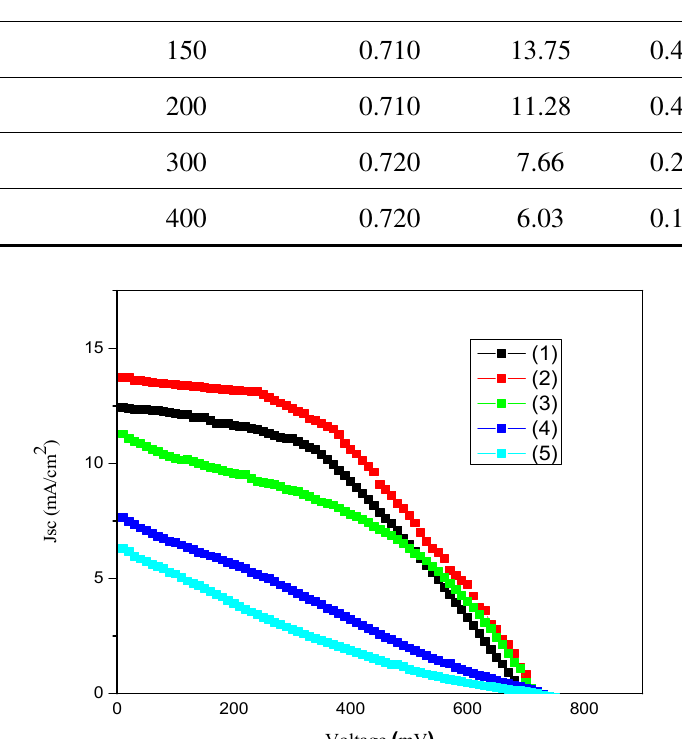
Table 4. The effect of sintering on the photovoltaic performance of the DSSCs with GNPs type 2 and NMP doped PEDOT:PSS hybrid CEs. Measured at 100 mW/cm 2 , cell active area: 0.8 cm 2 .